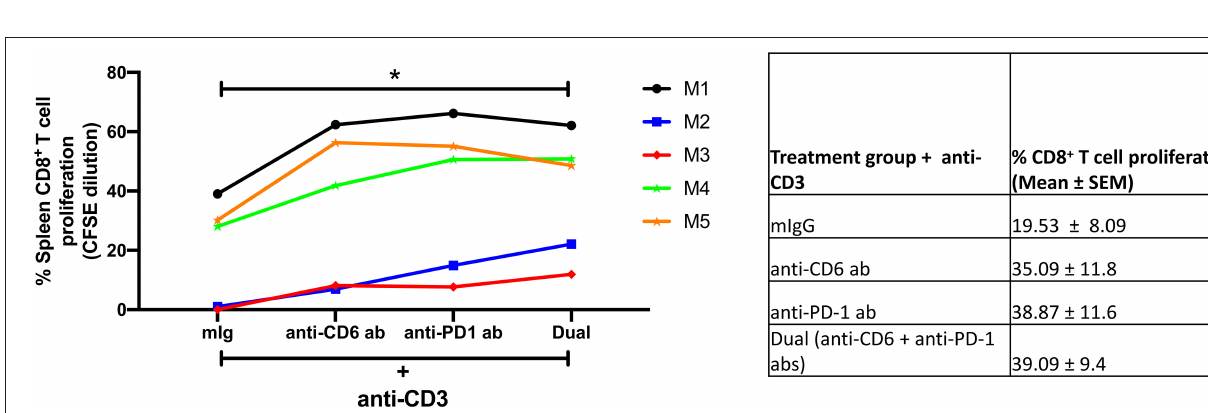
FIGURE 10 | Effect of targeting CD6 and PD-1 on CD8 + T cell proliferation. The proliferation of chronic splenic CD8 + T cells on day 5 following in vitro soluble anti-CD3 stimulation in the presence of anti-CD6, anti-PD-1, anti-CD6 plus anti-PD-1(Dual), or mIg. Shown to the right are means ± SEM from 5 macaques. For statistical analysis, Kruskal-Wallis with Dunn’s multiple comparison tests were performed. * p < 0.05.